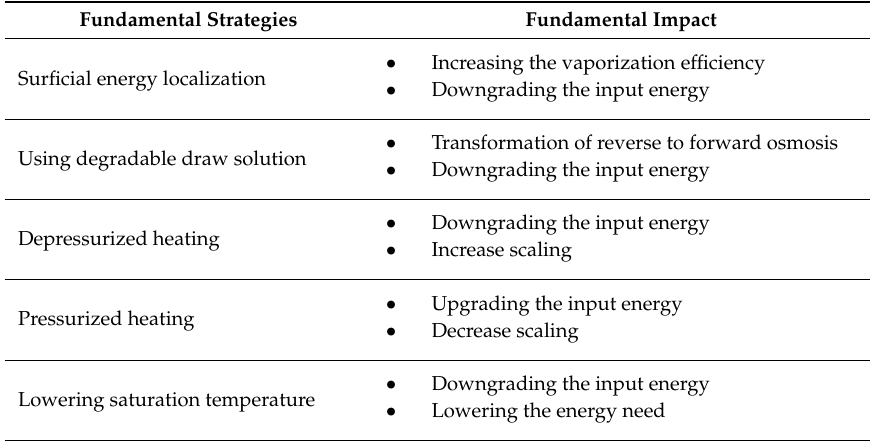
Table 1. Fundamental strategies and their resulting impact in water desalination .